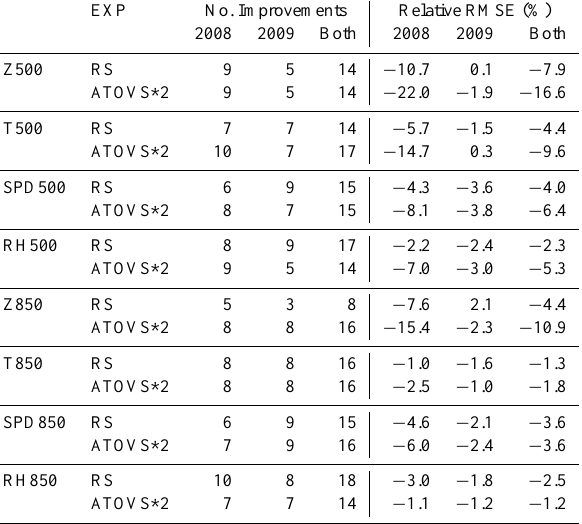
Table 2. Number of improved cases and relative RMSE (in %, see text for details) for experiments EXP-RS and EXP-ATOVS*2 (rela- tive to CONTROL) for different variables ( Z = geopotential height, T = temperature, SPD = wind speed and RH = relative humidity) at 500 and 850hPa, and for the cases of PREVIEW-DTS-2008, MEDEX-DTS-2009, and